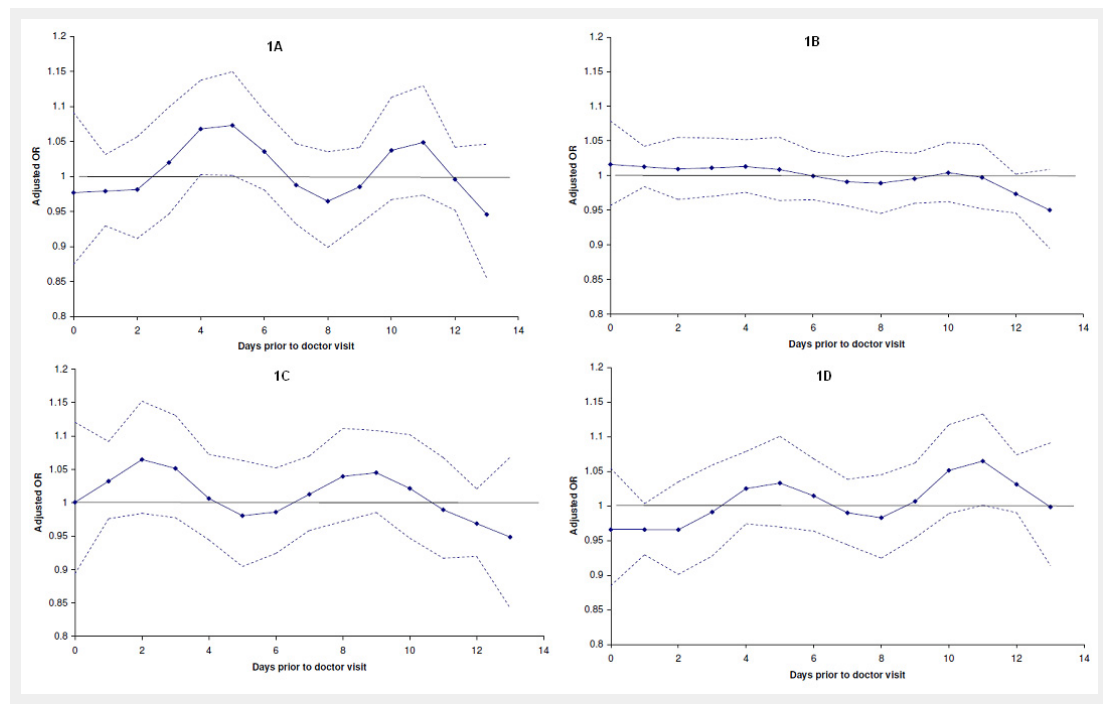
Supplementary file: Figure 1 Adjusted OR’s for doctor visits for respiratory symptoms per 10 µg/m 3 increase in TSP at separate lags in subjects with asthma (A), chronic bronchitis (B), COPD (C), and subjects who are healthy (D) as estimated in conditional logistic regression. All models were adjusted for flu prevalence, polynomial distributed lags of T, RH, AP, T 2 , RH 2 , and T*RH from lag 0 – 6 days up to 2 degrees of freedom, and average T, RH, AP, and T 2 from lag 7 – 13